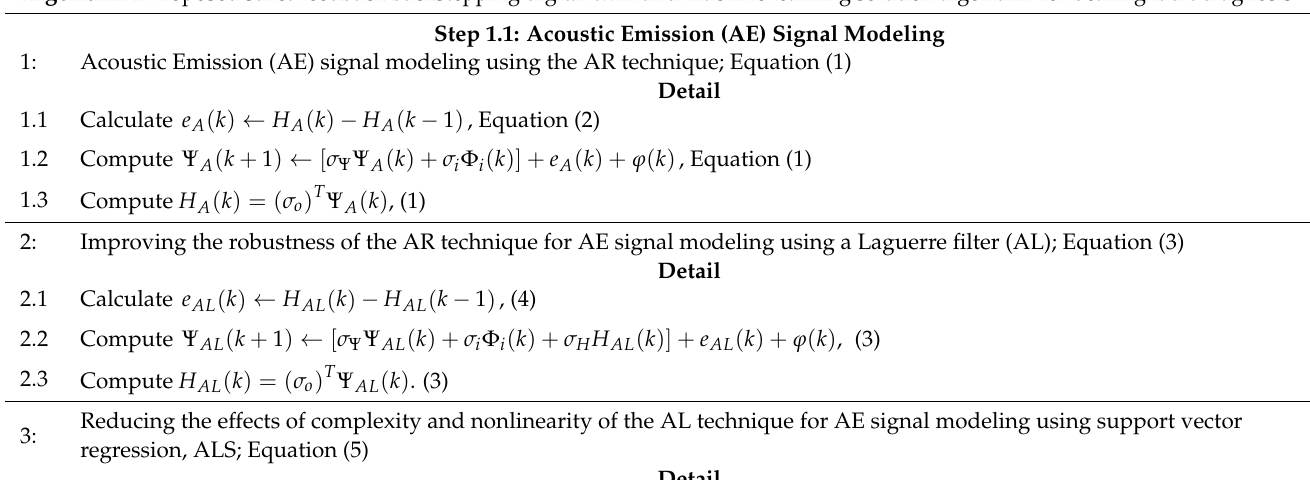
Algorithm 1 Proposed strict-feedback backstepping digital twin and machine learning solution algorithm for bearing fault